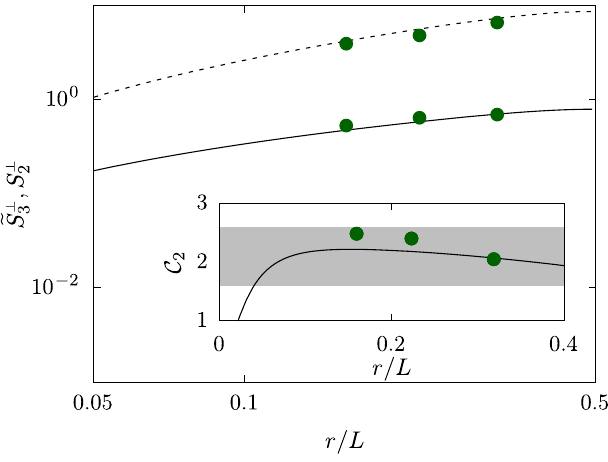
FIG. 3. Second-order and third-order transverse velocity struc- ˜ S ⊥ ture functions from DNS (note that 3 is computed using the absolute value of the velocity difference). Solid and dashed lines ˜ S ⊥ indicate the standard Eulerian measurements for S ⊥ 2 and 3 , respectively, while symbols denote those obtained from Lagran- gian tracking of fibers with St ¼ 0 . 4 and different lengths c=L ¼ 0 . 16 , 0.22, and 0.32. All quantities are made dimension- ˜ S ⊥ less with the box size L and the velocity root-mean-square; 3 is multiplied by 10 to enhance the visibility. The inset shows the Kolmogorov constant C 2 computed according to Eq. (6) using both methods; the gray area denotes the range of values determined experimentally by Noullez et al.